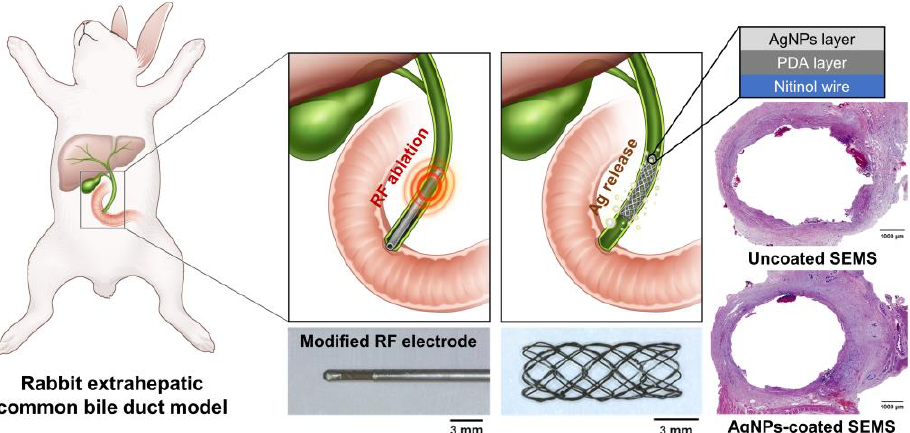
Figure 1. Schematic illustration of silver nanoparticles (AgNPs)-coated self-expandable metal stent (SEMS) placement immediately after radiofrequency (RF) ablation in a rabbit extrahepatic common bile duct model. AgNPs-coated SEMS suppressed bacterial growth and tissue hyperplasia due to inflammatory responses caused by local heating and stent placement.